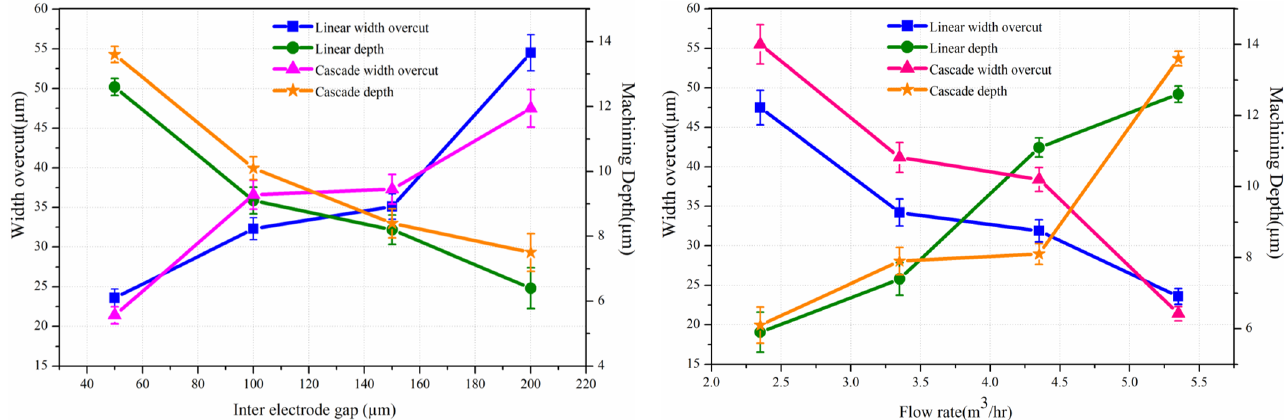
Fig. 4. Effect of interelectrode gap on width overcut and depth. Fig. 5. Effect of fl ow rate on width overcut